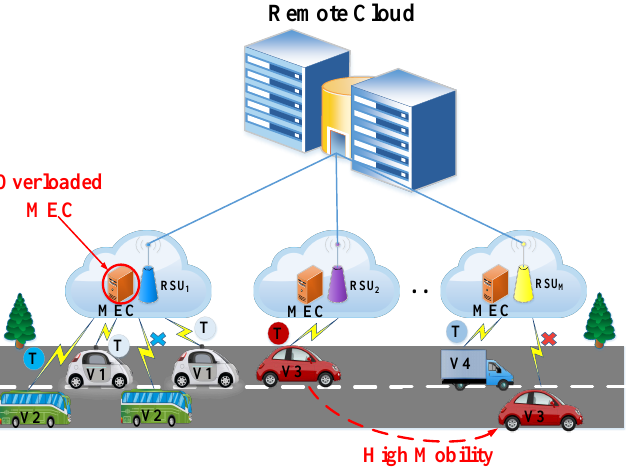
Figure 1. The problem of overloading and high mobility issues in vehicular networks. For example, f mec